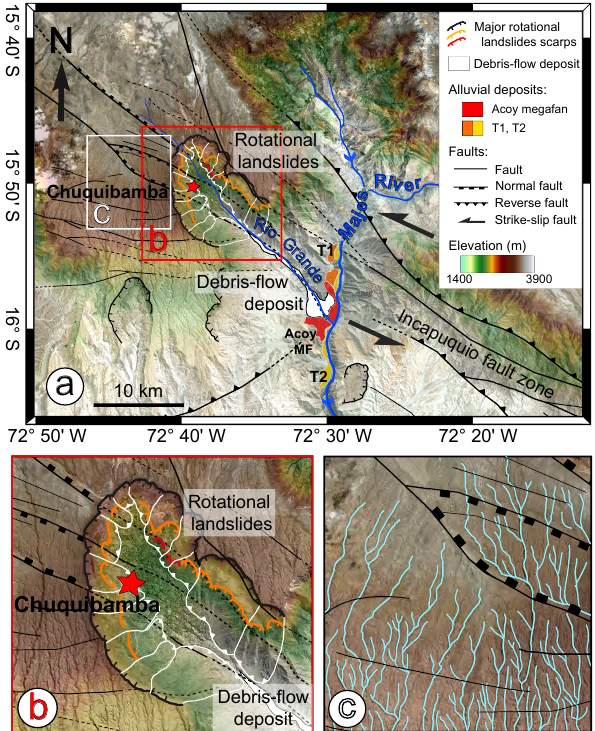
Figure 3. SRTM numerical elevation model overlay by Landsat im- age of the Chuquibamba destabilization zone. Coordinates are given in WGS 84 longitude and latitude (degrees). (a) Global view of the Chuquibamba area pointing major detachment scarps, debris-flow deposits, Acoy megafan, alluvial terraces and faults. (b) Close-up of the amphitheater-shaped scar of the rotational landslides show- ing the different head scarps. (c) Drainage network and